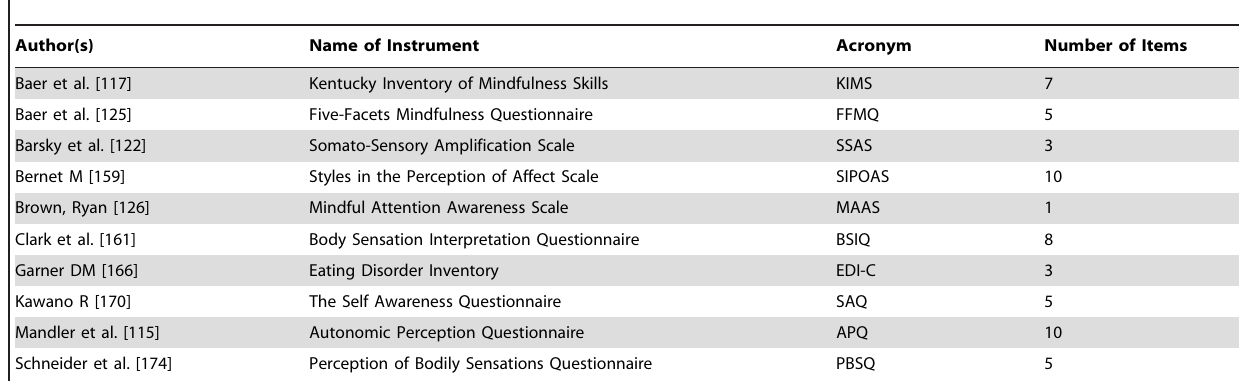
Table 2. Instruments with additional individual body awareness-related items included in conceptual